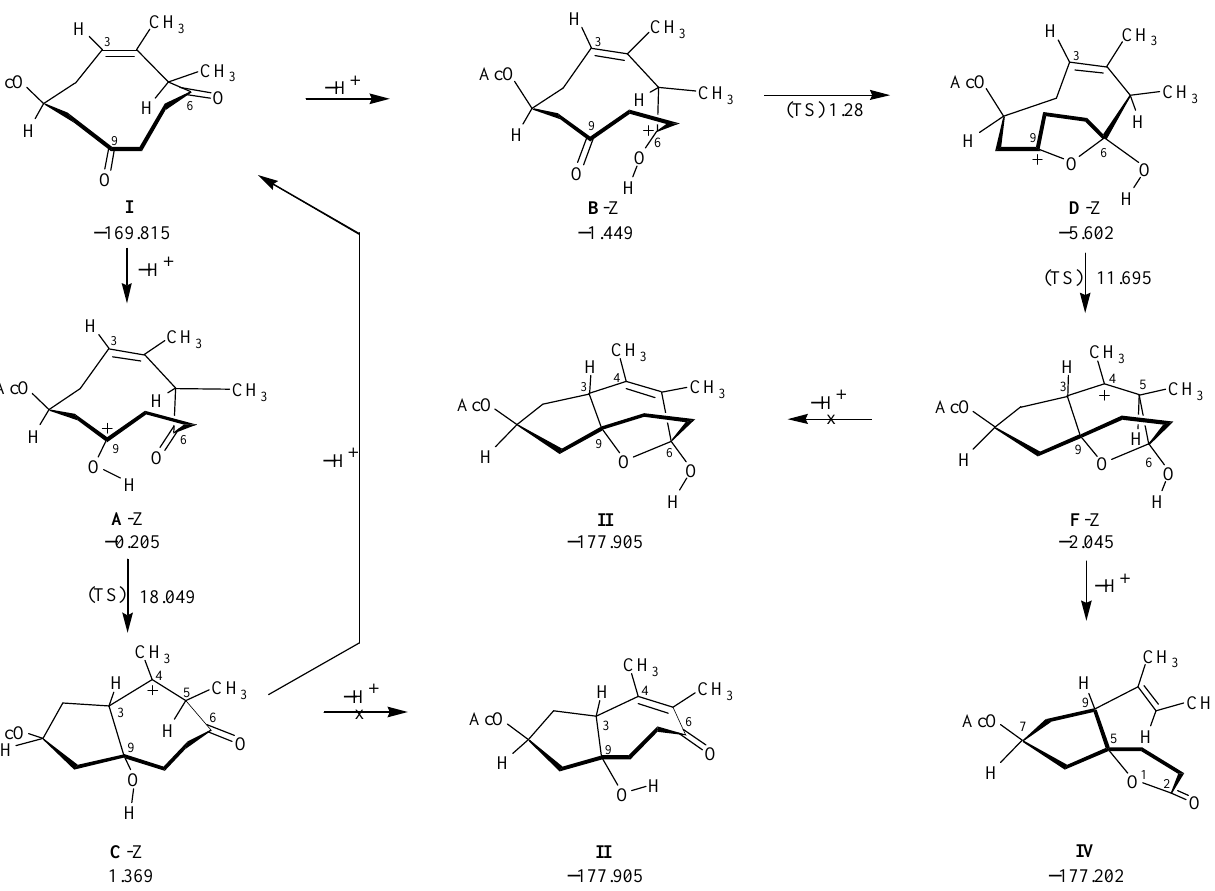
Figure 1. Results of the calculations for ( Z )-isomer. Heats of formation of the intermediates and prod- ucts of the corresponding transition states (TS) are given in